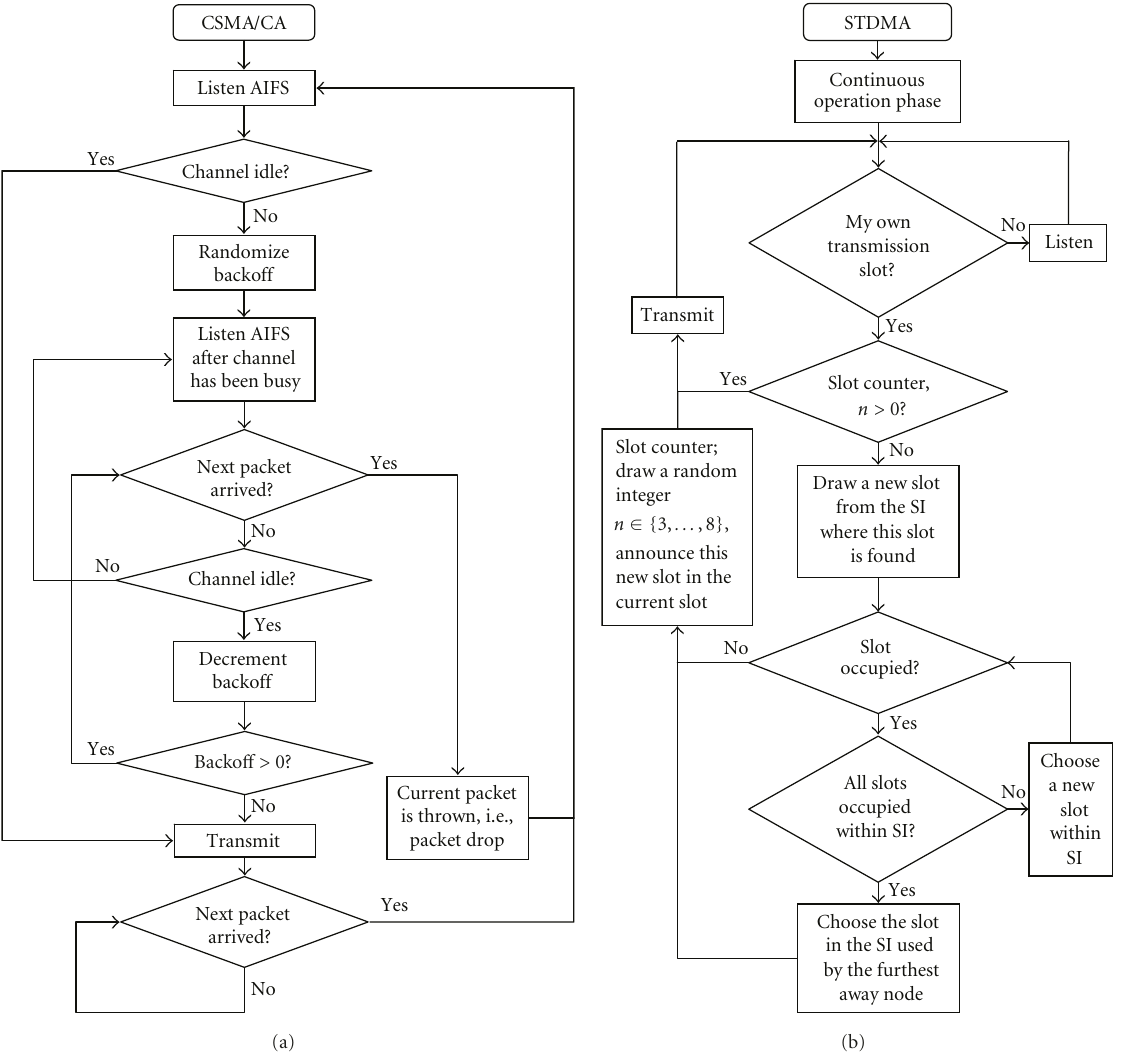
Figure 2: The two MAC procedures examined in this paper using a data tra ffi c model with broadcasted time-driven messages at predetermined heartbeat rates, (a) the CSMA procedure according to 802.11p and (b) continuous operation phase of STDMA.